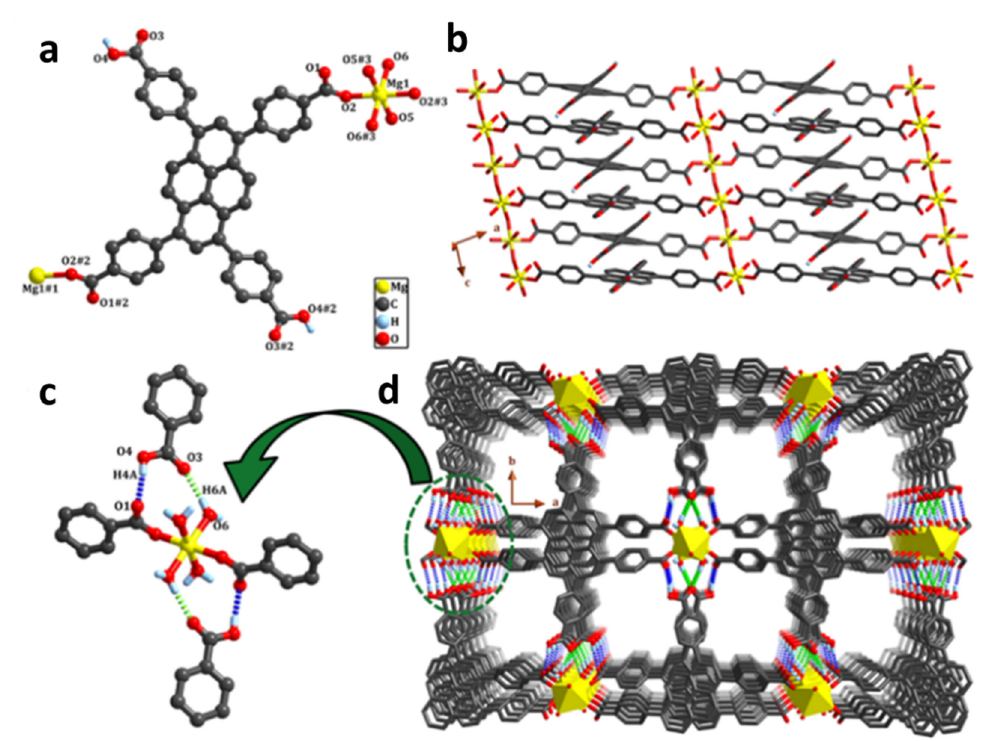
Figure 29. ( a ) Synergistic environment of H 2 TBAPy 2- and Mg 2+ . ( b ) TDL-MG 2D layer. ( c ) Strong O − H ··· O hydrogen bond interaction in TDL-MG. ( d ) TDL-3D MG’s supramolecular structure created via interlayer hydrogen bonding (reproduced with permission of American Chemical Society from ref. [111]).